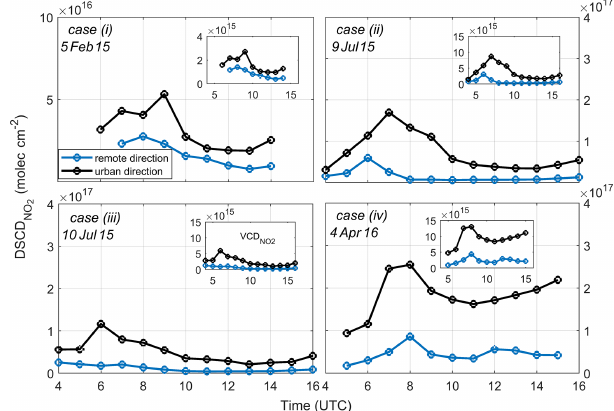
Figure 3. Tropospheric retrievals of diurnal SCD NO gle + 1 ◦ ) from MAX-DOAS measurements for the four selected case studies. The blue and the black curves correspond to the re- mote (W) and the urban ( S ) viewing direction, respectively. In the internal panels the corresponding tropospheric VCD NO shown. Please consider the different scale used in case